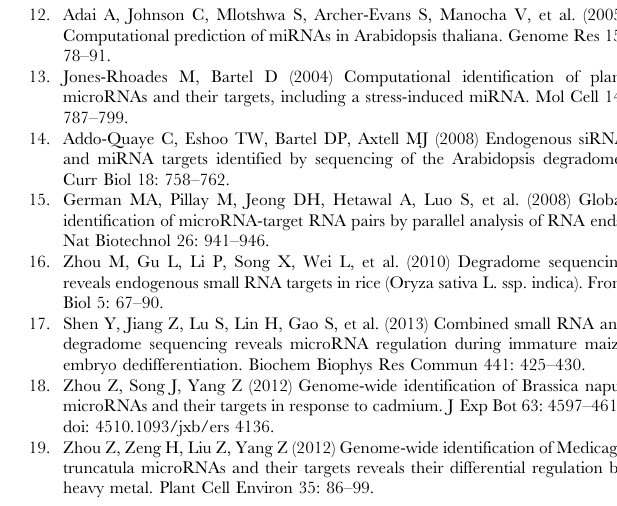
Figure S1 Length distribution of sRNAs in P. australis . (A) Size distribution of total sequences. (B) Size distribution of unique sequences. (TIF) Figure S2 Results from qRT-PCR of miRNAs in P. australis. PA2-1, 30-day-old diploid in vitro plantlets; PA4-1, 30-day-old autotetraploid in vitro plantlets; PA2-2, two-year-old diploid saplings; PA4-2, two-year-old autotetraploid saplings. Three independent biological replicates were performed. Values are means 6 SD (n= 3). The expression levels of miRNAs were normalized to U6. The normalized miRNA levels in the PA2-1 were arbitrarily set to 1. *: Statistically significant differences between PA2 and PA4 under the same developmental stages (p- value was less than 0.05). Table S1 Quantitative RT-PCR validated miRNAs and their targets primers. Table S2 Categories and statistical summary of sRNAs in P. australis . Table S3 The sequences of conserved miRNAs identi- fied from P. australis . Table S4 The sequences of novel miRNAs identified from P. australis . Table S5 Identified targets of miRNAs involved in P. australis by degradome